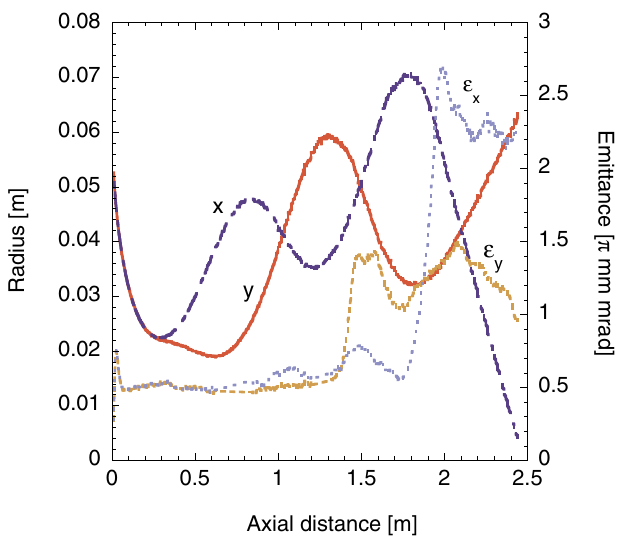
FIG. 5. (Color) Beam envelope (2 rms) and normalized edge emittance evolution in ESQ section for the first